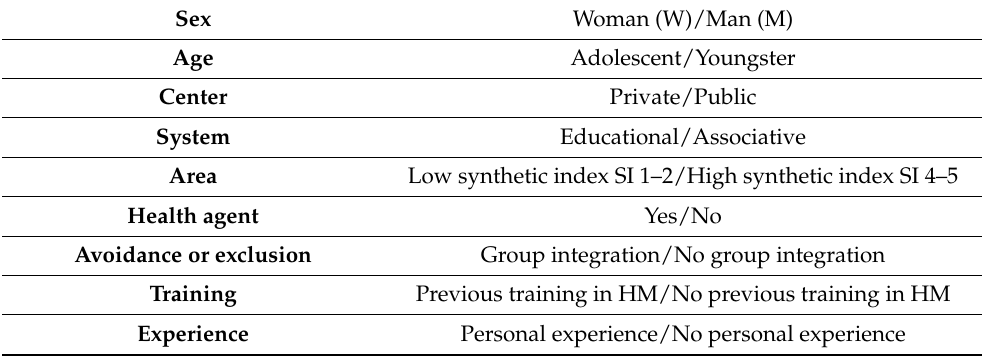
Table 1. Sample “Youth” (Y).